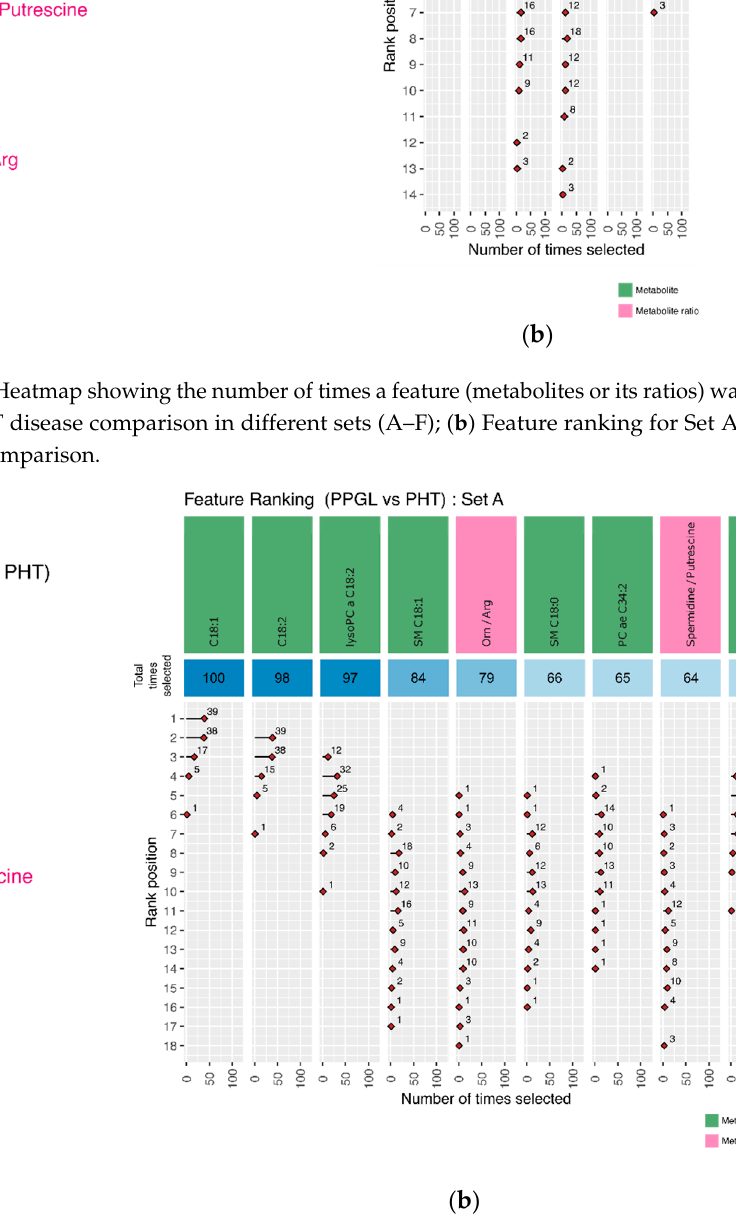
Figure A5. ( a ) Heatmap showing the number of times a feature (metabolites or its ratios) was selected for PPGL vs. PHT disease comparison in different sets (A–F); ( b ) Feature ranking for Set A in PPGL vs. PHT disease comparison.